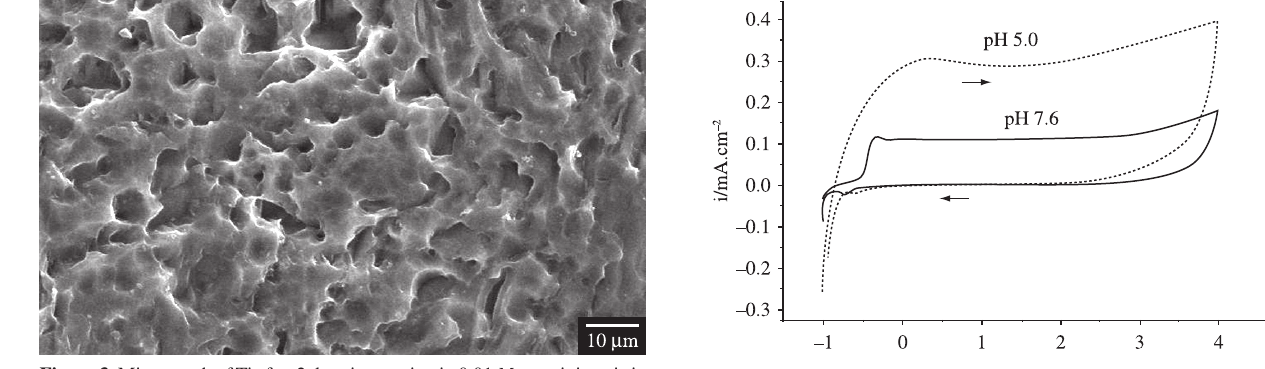
Figure 3. Micrograph of Ti after 2 days immersion in 0.01 M containing citric acid solution, magnification × 2000.